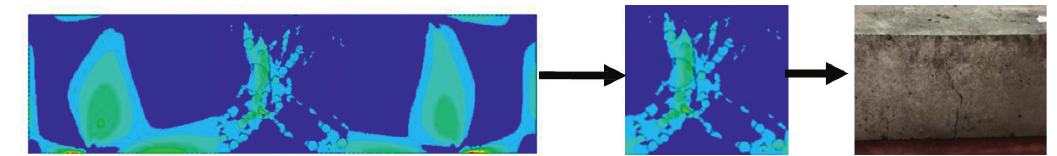
Figure 4: Middle section of the beam where the crack occurs.